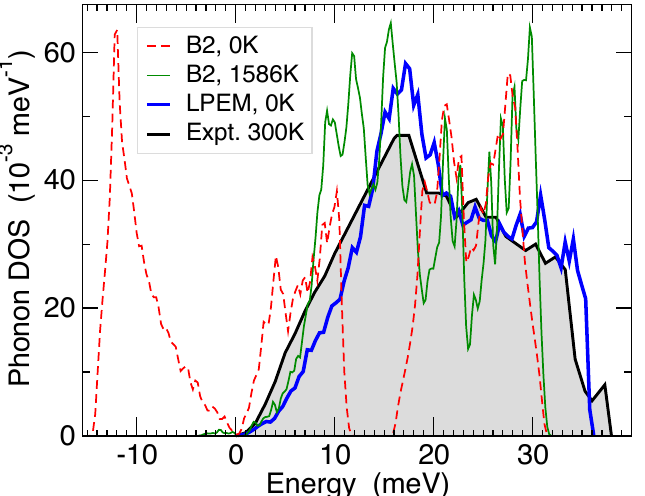
Figure 7. (color online). Phonon density of states assessed from neutron diffraction [44] (black, shaded) and computed for NiTi austenite using several methods: small displacements from the stable LPEM austenitic representative structure [20] at 0K (thick blue) and unstable B2 at 0K (dashed red); large displacements from B2 in MD at 1586K using ThermoPhonon [46] (thin green line). Interatomic interactions affect energy and equilibrium atomic positions, shown